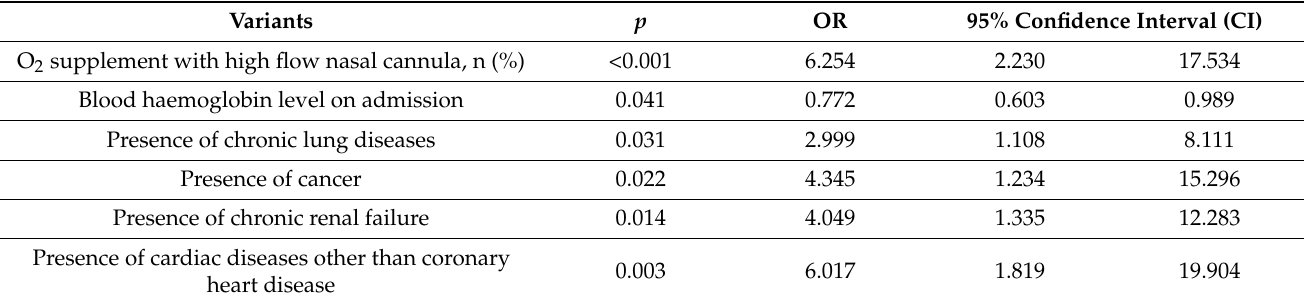
Table 2. Results of multivariate analysis of mortality risk factors for